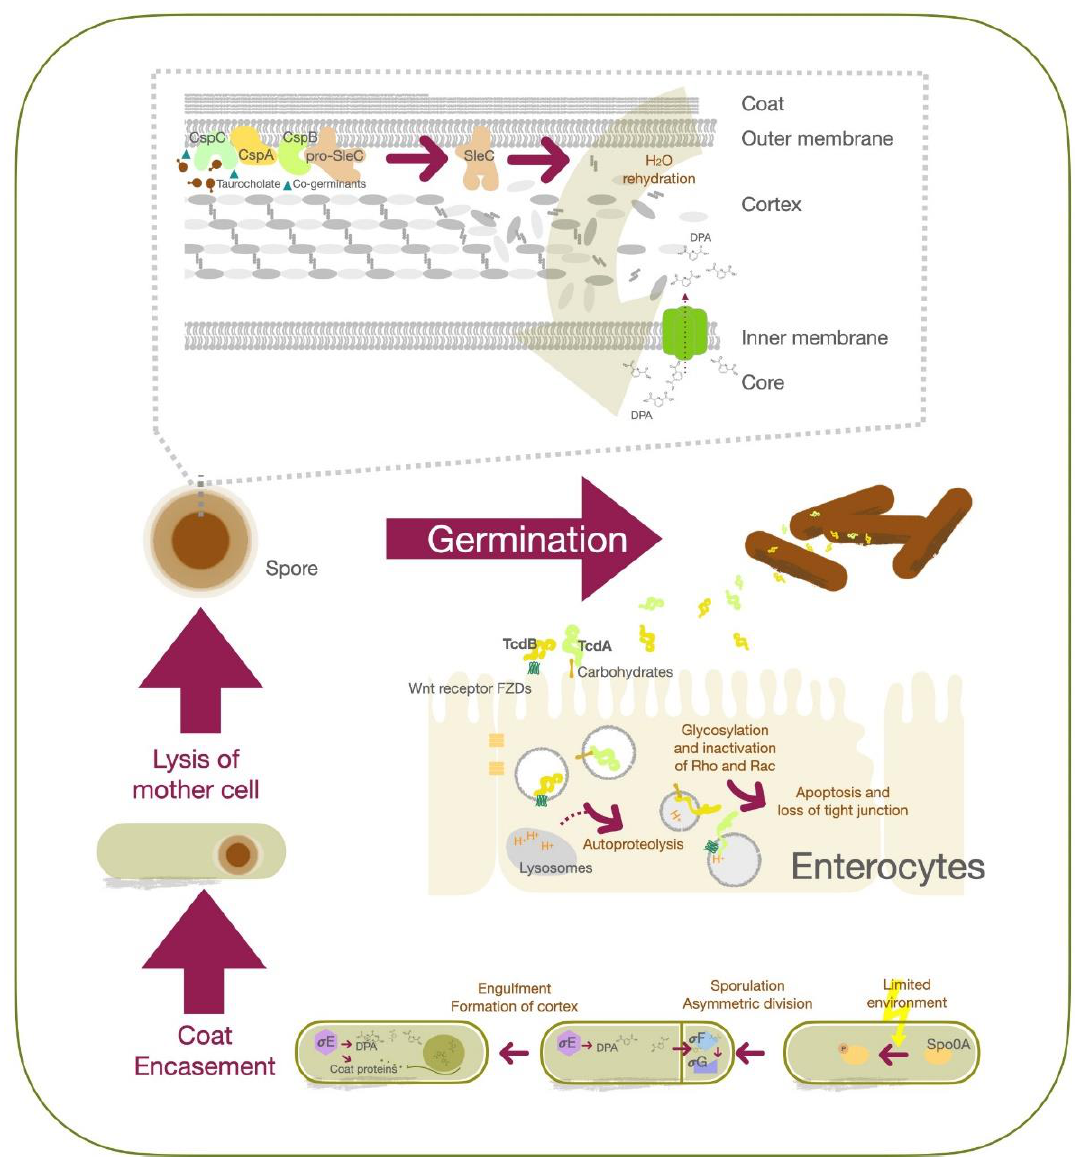
Figure 1. Schematic illustration of C. difficile germination, sporulation, and the molecular mechanism of toxins action in epithelial cells.